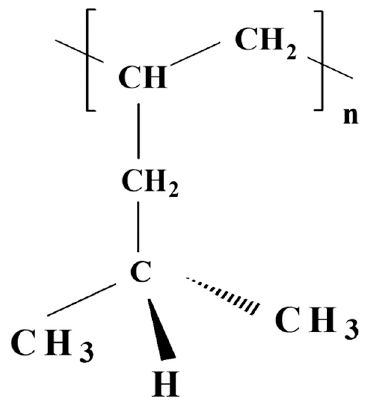
Figure 1. Repeating unit of PMPentene.